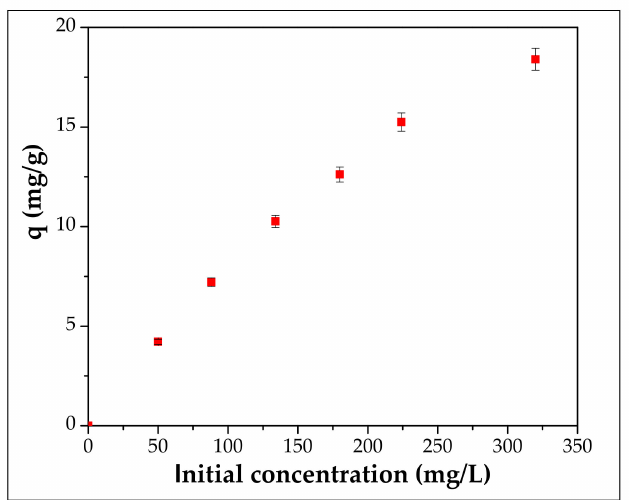
Figure 7. E ff ect of initial concentration on the adsorption of Cd 2 + onto